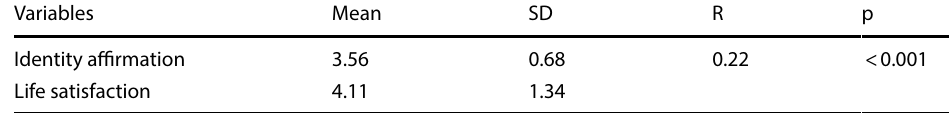
Table 4 The relationship between identity affirmation and life satisfaction